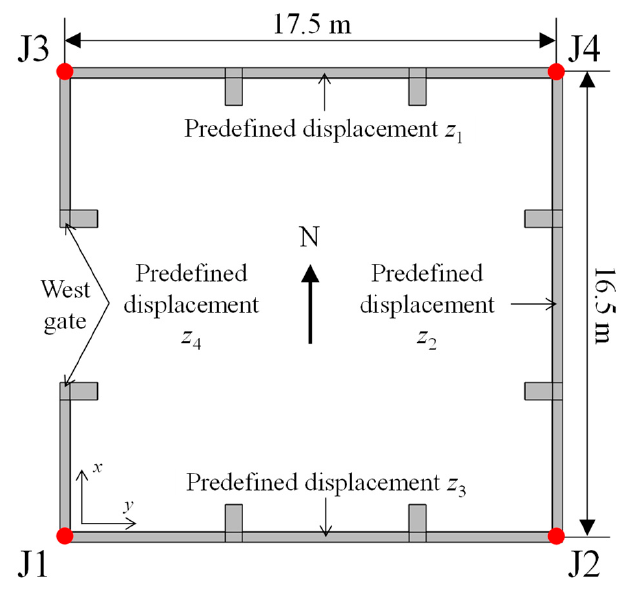
Figure 7. Boundary conditions of the bottom frames.